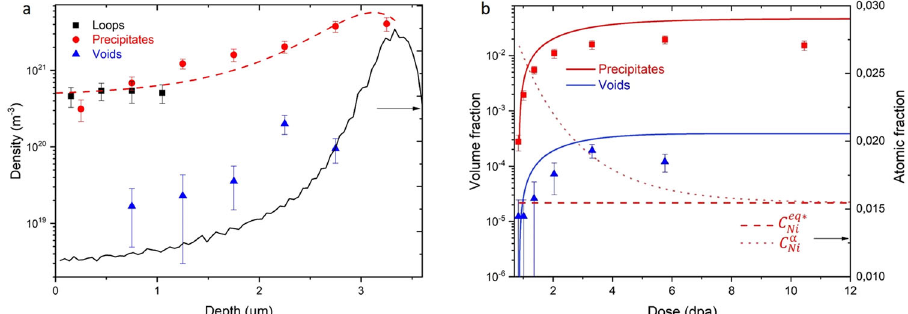
Fig. 2 Evolution of Ni content and microstructure in the function of radiation depth and dose in Fe-3.3 at% Ni. a Experimental densities of dislocation loops (full squares), precipitates (full circles), and voids (full triangles) with SD error bars, vs. depth at T = 400 °C. b The nonhomogeneous microstructure is related to the spatial variation of the radiation dose by means of the SRIM and TRIM code computing the radiation damage in terms of displacement per atom (dpa). The volume fraction of precipitates and voids, and the Ni content of the matrix α , c α and predicted by the model (lines). The Ni content in the matrix α , converges to the metastable equilibrium atomic fraction of Ni c eq (cid:1)